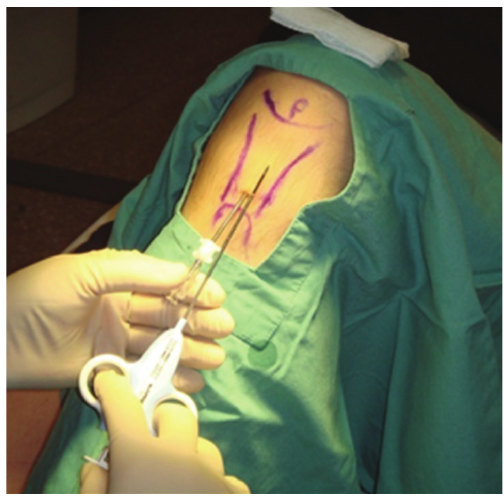
Figure 5: Trucut biopsy of patella tendon for tenocyte harvesting (Courtesy of M Zheng).